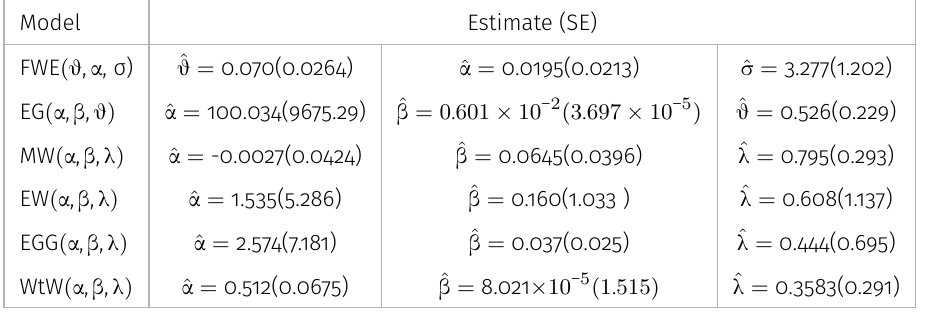
Table V. The MLEs and SEs of the parameters of the distributions for survival times data. Model Estimate (SE)